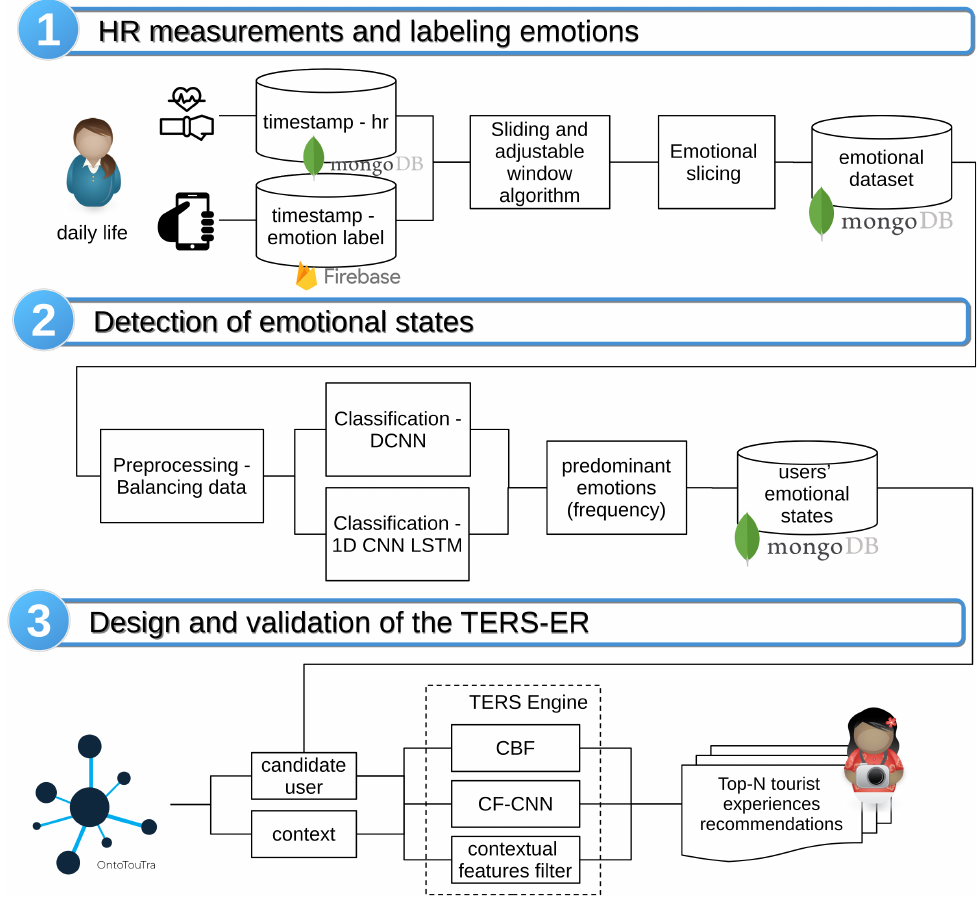
Figure 1. Method